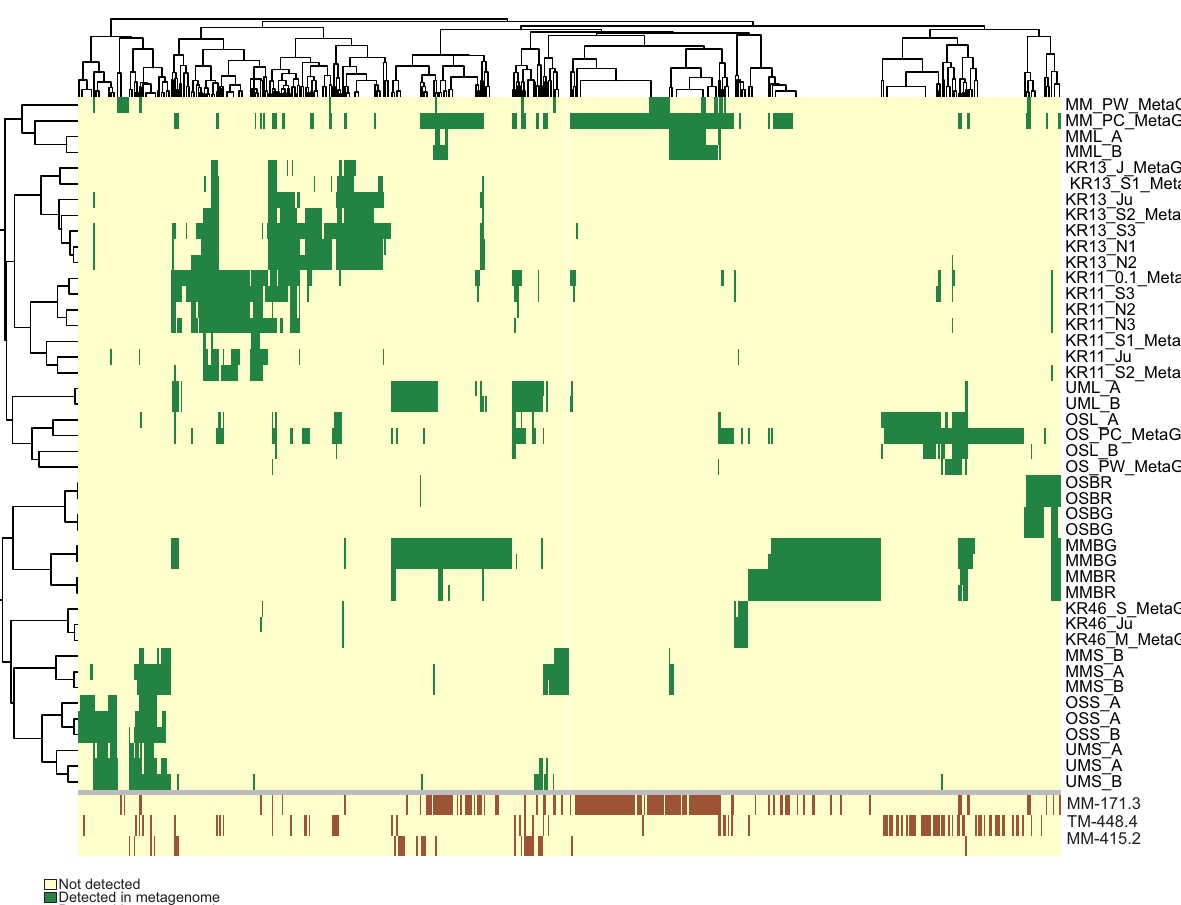
Fig. 3 Distribution pattern and transcription status of the FSGD genome clusters along different metagenomes and metatranscriptomes. Each column represents a genome cluster of reconstructed MAGs/SAGs of the deep groundwater datasets of this study. The top heatmap depicts the presence (colored in green) of each genome cluster along metagenomics datasets originating from different boreholes of the two sampled sites. The bottom heat map represents the transcription status of the genome cluster representatives in the metatranscriptomes originating from different boreholes of the Äspö HRL (brown). Clusters with all zero values have been removed from the plot (in total 14 clusters that are solely represented by